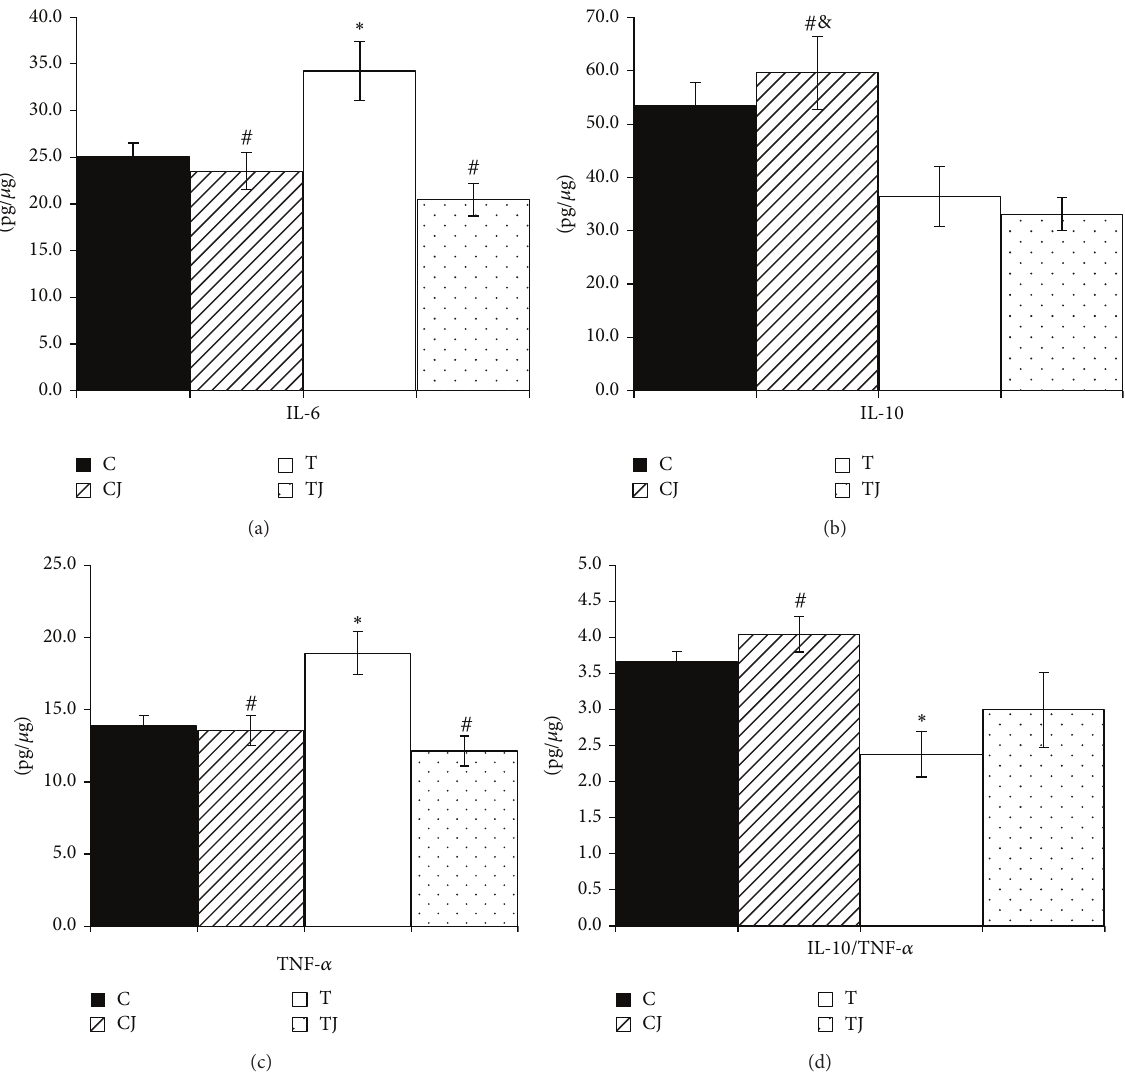
Figure 3: IL-6 protein expression (a), IL-10 (b), TNF- 𝛼 (c), and IL-10/TNF- 𝛼 ratio (d) in 21-day-old offspring colon. C: offspring of dams fed control diet; CJ: offspring of dams fed control diet supplemented with 0.5% freeze-dried Jussara powder; T: offspring of dams fed diet enriched with hydrogenated vegetable fat, TFAs; TJ: offspring of dams fed diet enriched with TFAs supplemented with 0.5% freeze-dried Jussara powder. Data are means ± SEMs of 7–11 determinations per group. ∗ 𝑃 < 0.05 versus C. # 𝑃 < 0.05 versus T. & 𝑃 < 0.05 versus